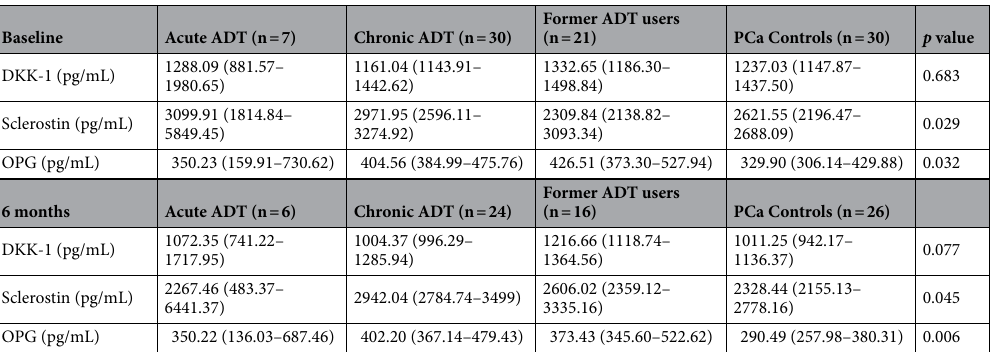
Table 2. Baseline serum levels of bone markers. Results are presented as median (95% CI). DKK1 Dickkopf-1, OPG osteoprotegerin.